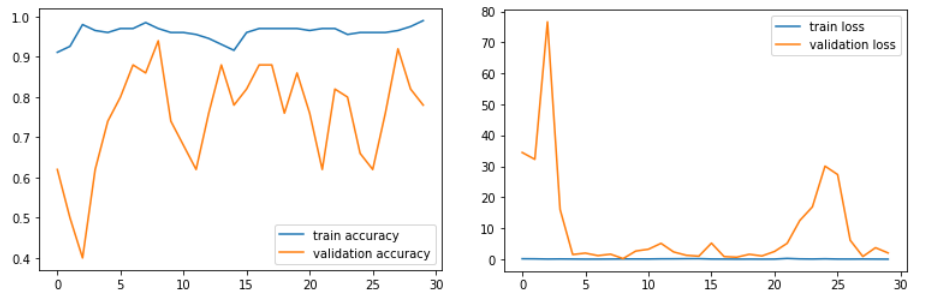
Figure 11. Accuracy and loss for training and validation (Dataset 2).